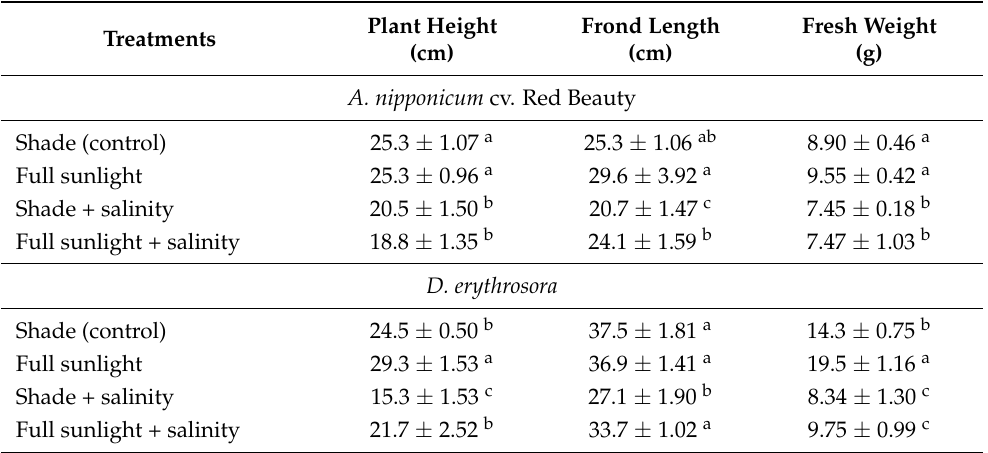
Table 1. Effect of abiotic stresses on growth characteristics of two hardy ferns. Within a column means followed by the same lowercase letter are not significantly different at p ≤ 0.05 (ANOVA, Tukey’s HSD post hoc test).